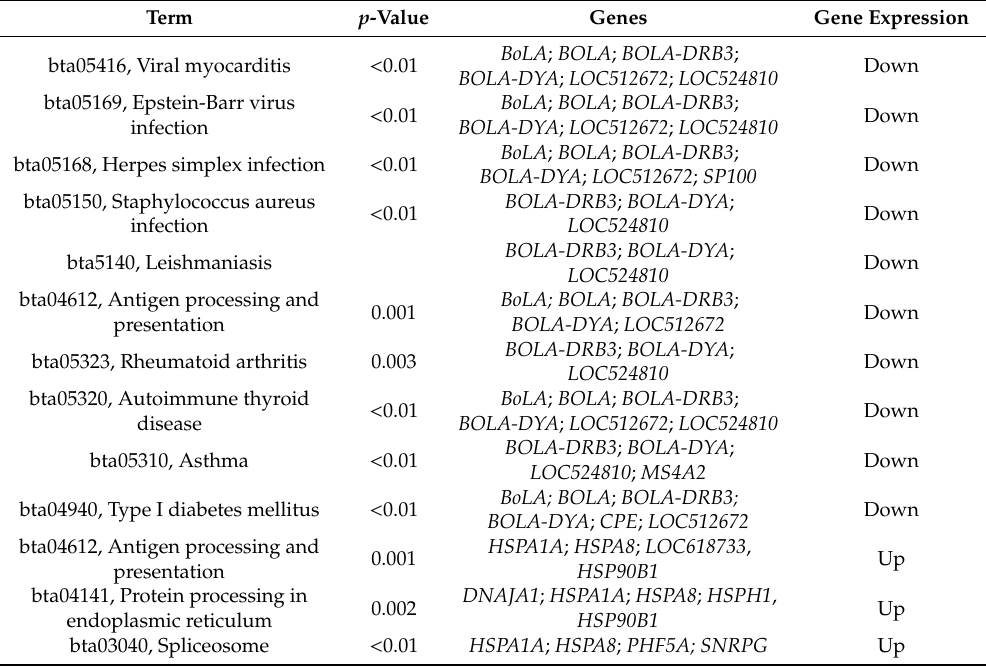
Figure 4. The top-20 pathways of HS-vs.-TN (total) of Kyoto Encyclopedia of Genes and Genomes Figure4. Thetop-20pathwaysofHS-vs.-TN(total)ofKyotoEncyclopediaofGenesandGenomesenrichment. enrichment. Table 5. Significantly enriched KEGG pathways of downregulated and upregulated Table 5. Significantly enriched KEGG pathways of downregulated and upregulated genes.